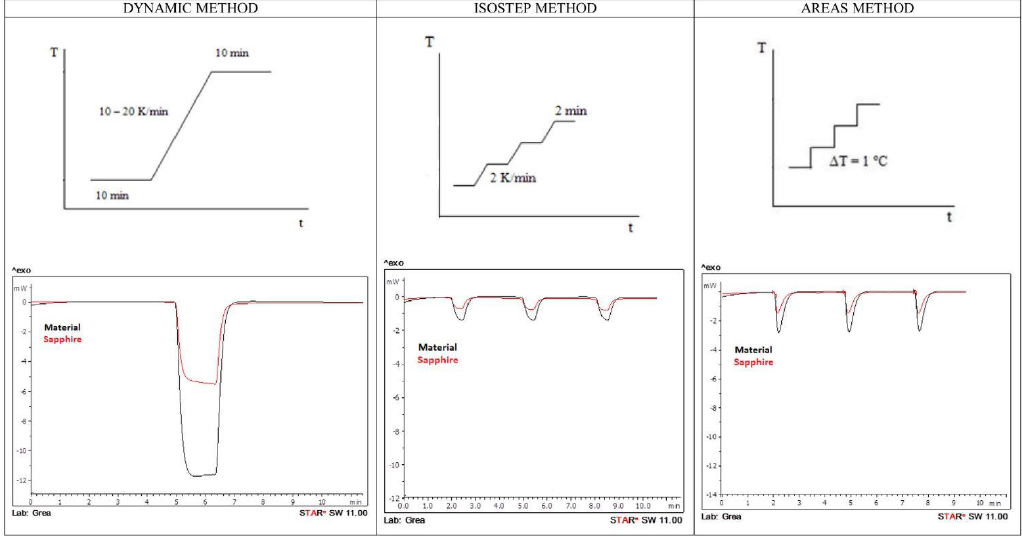
Figure 16. Different temperature programs for C p measurements, after [43]. Table 9. Studies on C p measurements of PCMs.